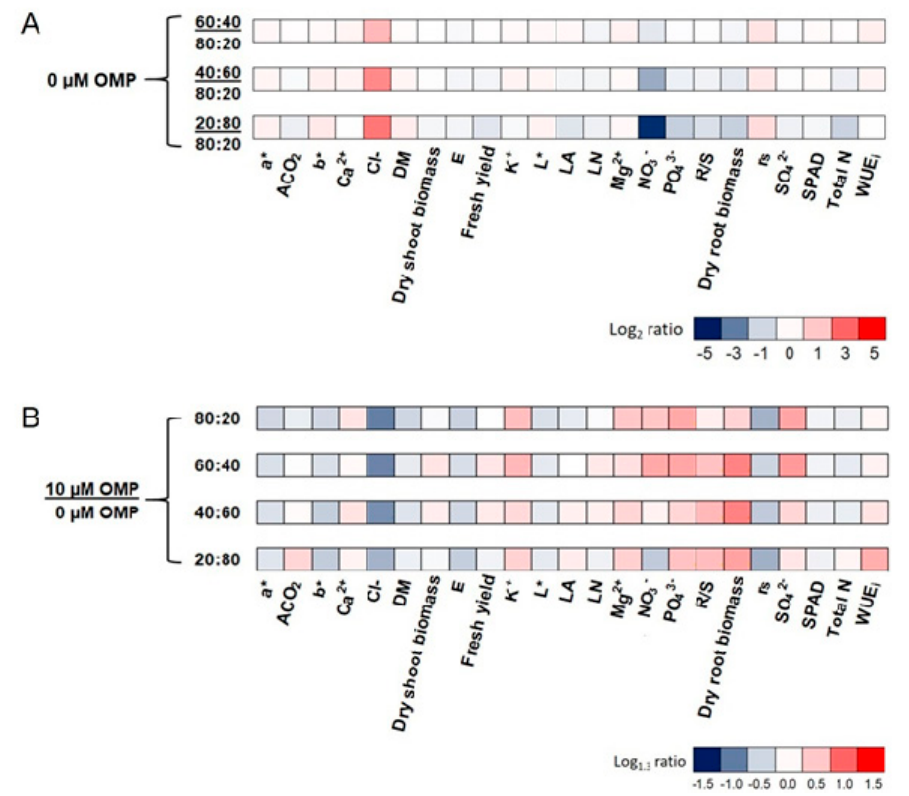
Figure 3. Heat map analysis summarizing the plant response to di ff erent NO 3 − :Cl − ratios (80:20, 60:40, 40:60, and 20:80) and OMP treatments. Results were calculated as Logarithm base 2 (Log2) of 60:40, 40:60, and 20:80 / 80:20 in control plants ( A ) or Logarithm base 1.3 (Log1.3) of 10 µ M OMP / 0 µ M OMP control in plants grown at di ff erent N ( B ) and visualized using a false color scale with red indicating an increase and blue a decrease. No di ff erences were visualized by white squares.